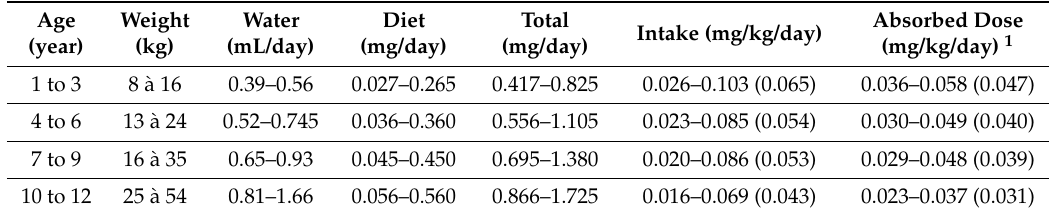
Table A1. Absorbed doses calculated from the McClure [1] data on intakes from water and diet 1